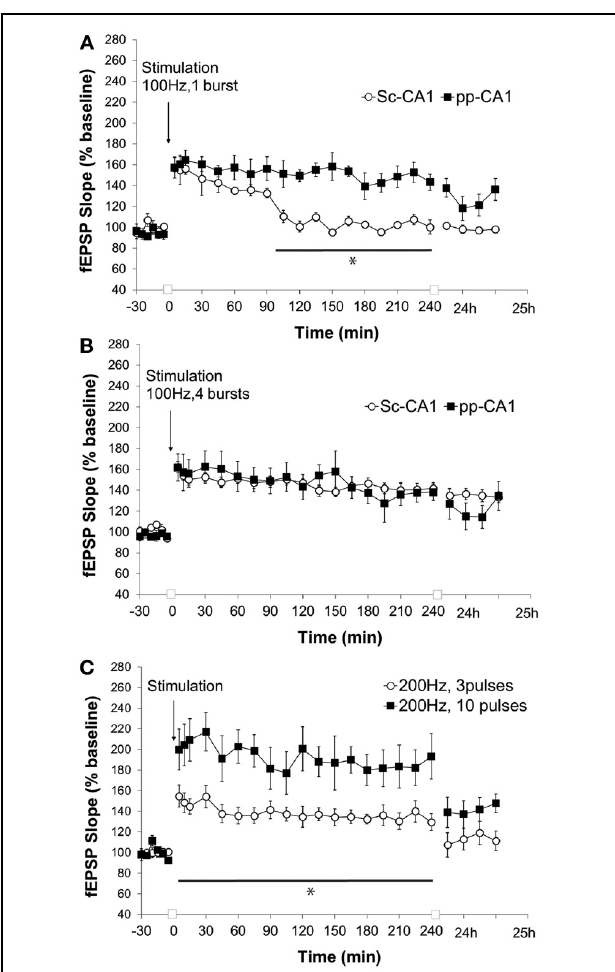
FIGURE 5 | High frequency stimulation (100Hz) at different strengths elicits LTP of differing durations at the pp-CA1 and Sc-CA1 synapses. (A) High frequency stimulation (HFS) with a weak tetanus of 100Hz (1 burst of 100 pulses) resulted in short term potentiation at the Sc-CA1 synapse and LTP at the pp-CA1 synapse in freely behaving rats. Synaptic potentiation at pp-CA1 synapses was significantly more prolonged than potentiation at SC-CA1 synapses (ANOVA). The line with the asterisk indicates individual time-points that were determined to be significant in the pp-CA1 responses compared to the Sc-CA1 responses, using post-hoc Fisher’s LSD test. (B) Strong HFS with 100Hz (4 bursts of 100 pulses) elicited comparable potentiation at the two synapses. (C) HFS with a weak or strong tetanus of 200Hz [3 bursts (wHFS) or 10 bursts (HFS)] resulted in LTP of differing amplitude at pp-CA1 fEPSPs from freely behaving rats. LTP elicited with 200Hz, 10 pulses was significantly larger than LTP elicited with 200Hz, 3 pulses (ANOVA). The line with the asterisk indicates individual time-points in the 10 pulse group that were determined to be significant from the 3 pulse group, using post-hoc Fisher’s LSD